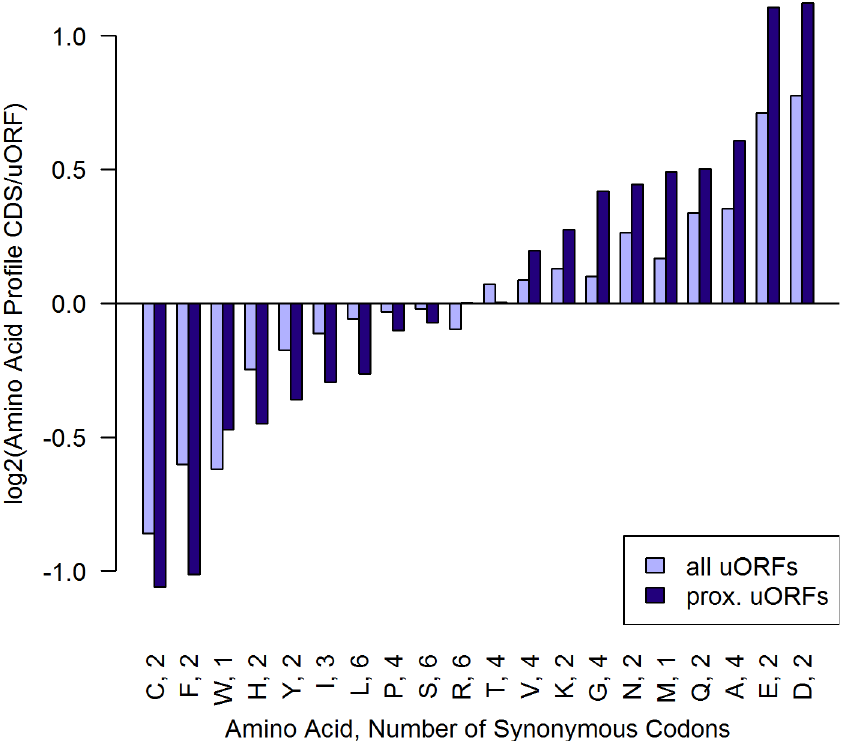
Fig 1. Comparison of amino acid usage among CDSs and uORFs. Y-axis values were calculated as the log2 of the ratio of amino acid usage in CDSs and uORFs for each individual amino acid, taking BSF stage as an example (for all stages see S9 Fig). A positive value represents amino acids expressed more frequently in CDSs than in uORFs and vice versa. The stop codon "s" is expressed by a factor 17.5 more frequent in uORFs (due to length bias). Length bias for methionine (start codon) is eliminated by not counting the first ATG of each sequence. To keep a y-range allowing comparison of different amino acids, "s" wasn’t included into the plot. The amino acid usage bias is especially pronounced in the subset of proximal uORFs (uORF to CDS distance < 80 nt). (n alluORFsBSF = 15,348 n prox.uORFsBSF =